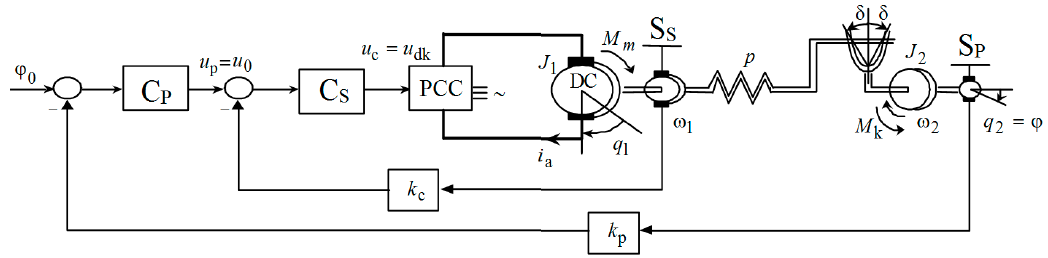
Figure 2. Physical model of the drive system with a nonlinear elastic coupling.